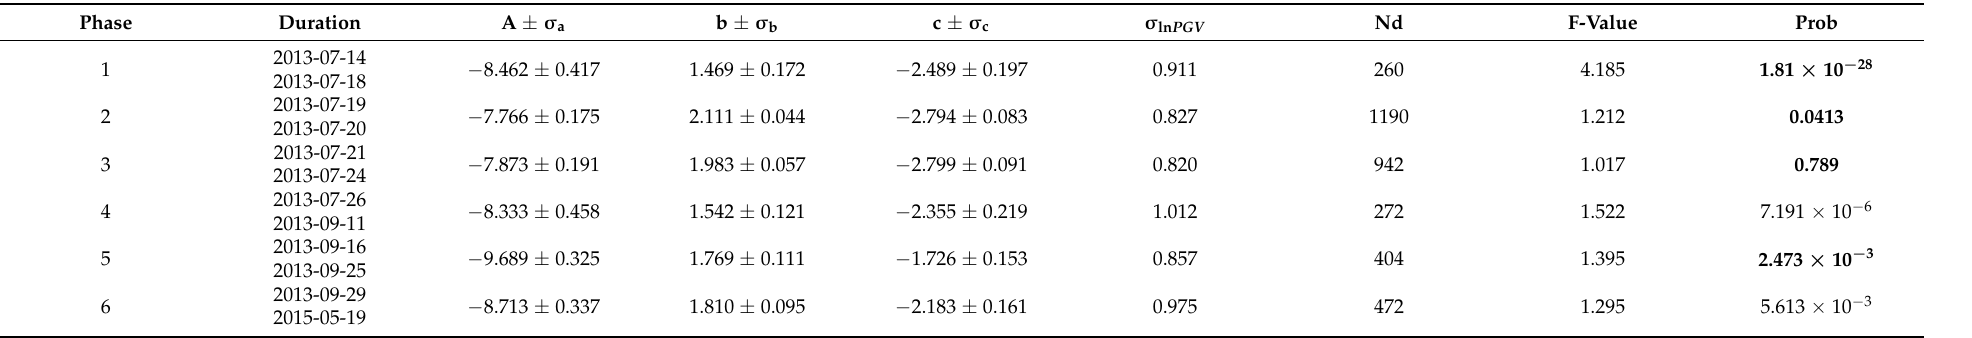
Table 1. Inferred coefficients together with the uncertainty of the GMPE by using data relative to the considered phases of the project. The duration of each phase is listed in the second column. Nd indicates the number of used PGVs . F-value is the value of the statistic used in the F-test and is governed by the Fisher distribution. Prob is the probability of finding an F-value equal or larger than the one observed value in the assumption that the null hypothesis (Ho: No difference in variances between old and new model) is true. More specifically, the probability that the obtained results could have happened by chance. Probabilities in bold indicate that the new inferred model can be used instead of the previous one. As for phase 1, the current model is compared with the reference model reported in Equation